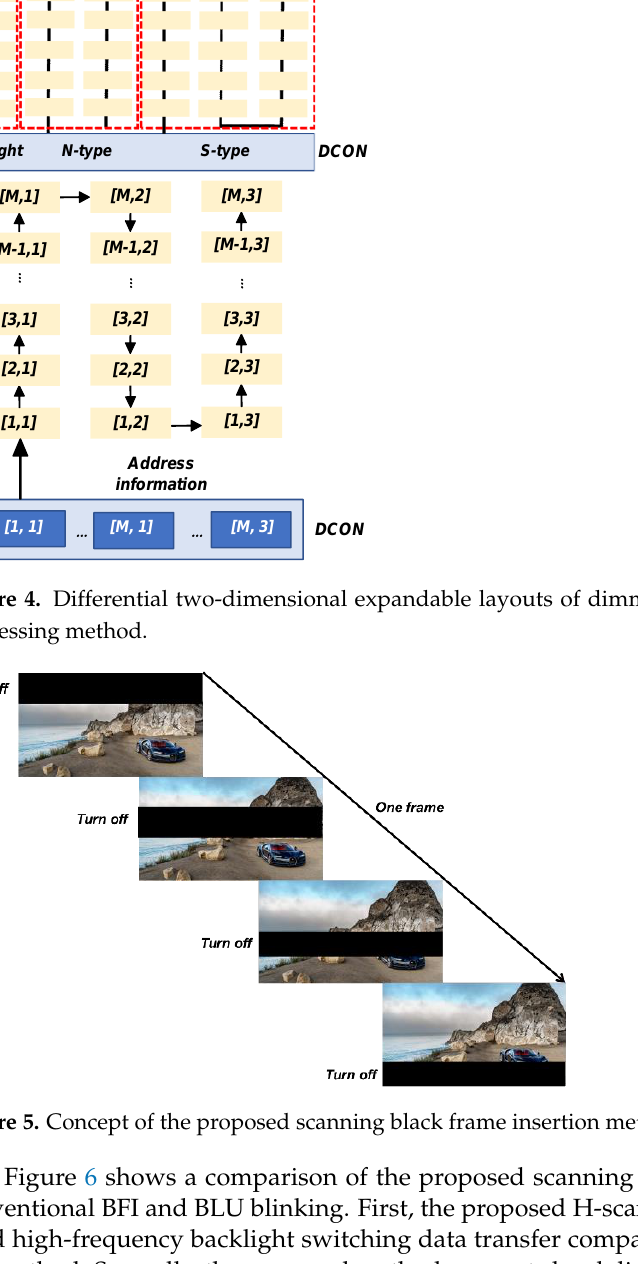
Figure 5. Concept of the proposed scanning black frame insertion method.